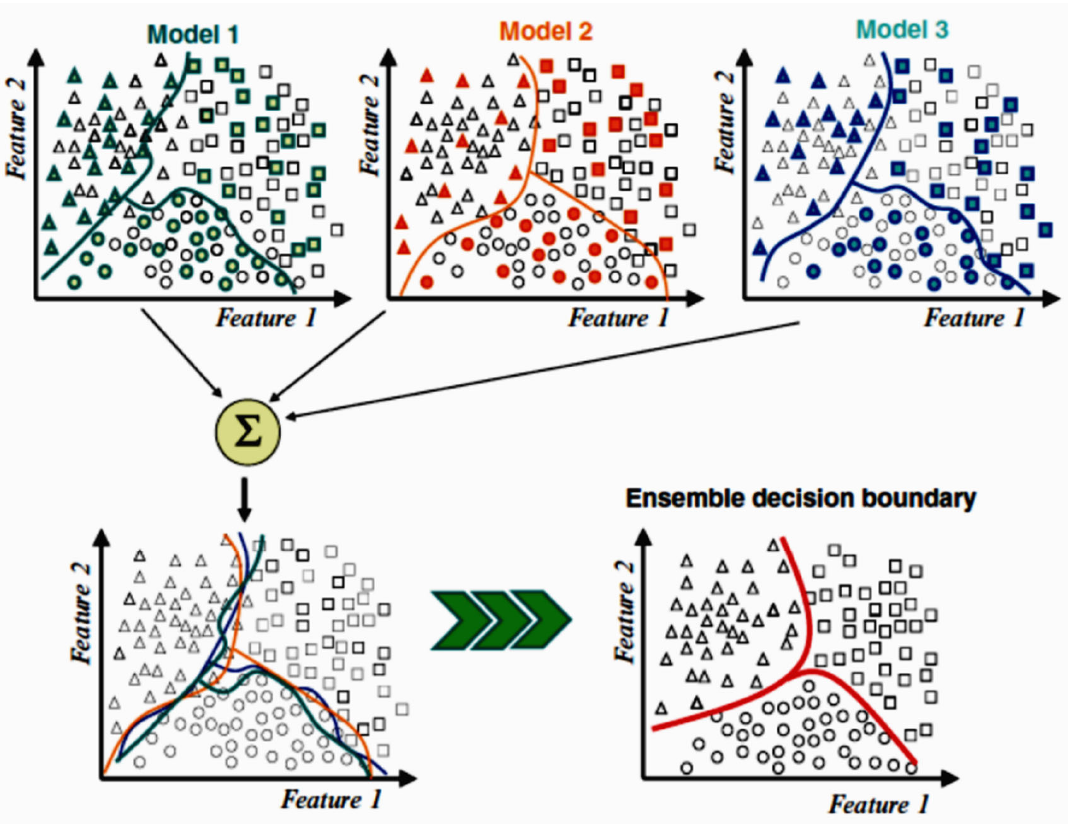
Figure 5. Variability reduction by application of three ensemble learning models (modified from [54]).